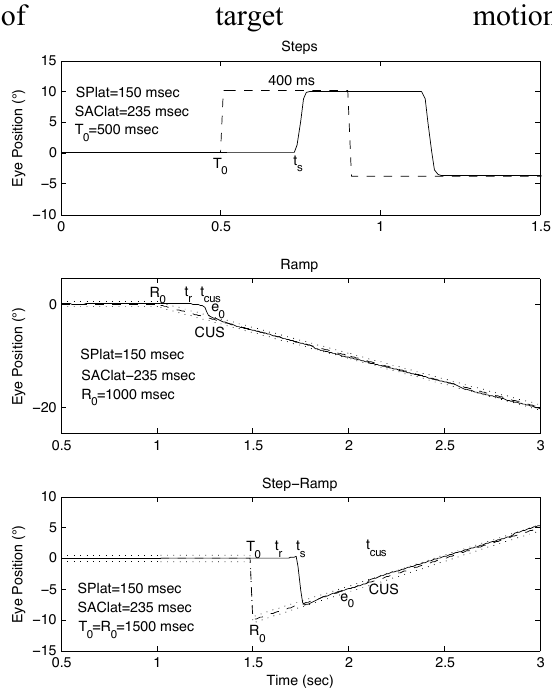
Figure 1. Examples of classical stimuli and simulated responses using the behavioral OMS model. (top) Positive and negative steps separated by 400 msec. (middle) Negative ramp of -10°/sec. (bottom) Step-ramp (SR, Rashbass, [SR: